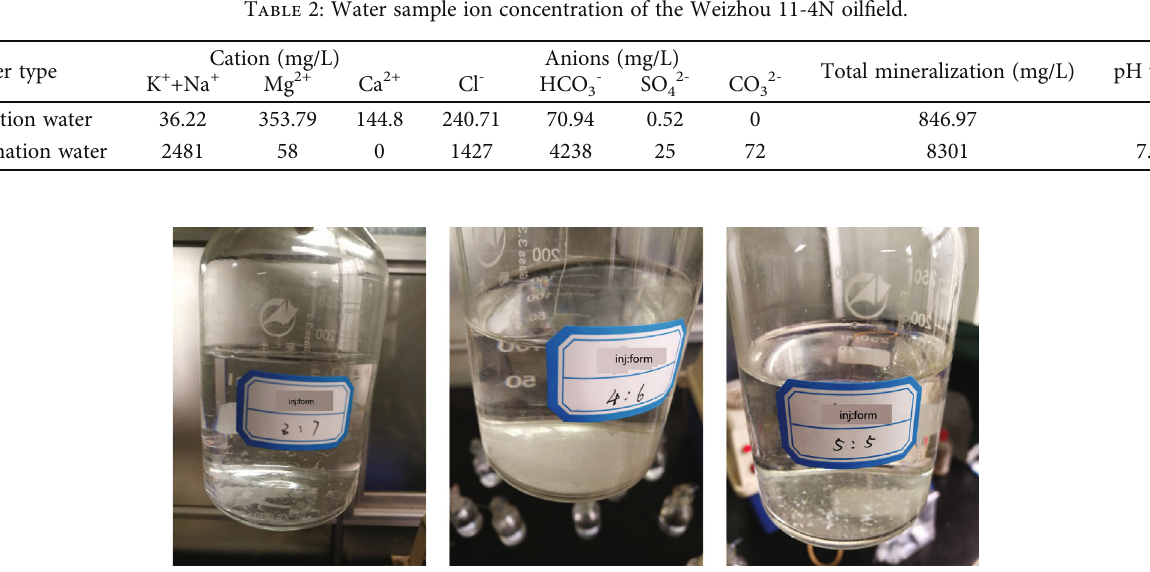
Figure 3: Some samples with serious scale after 140 days of